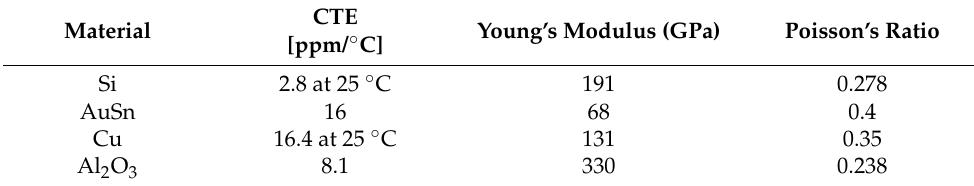
Table 7. Materials properties of investigated assemblies’ components